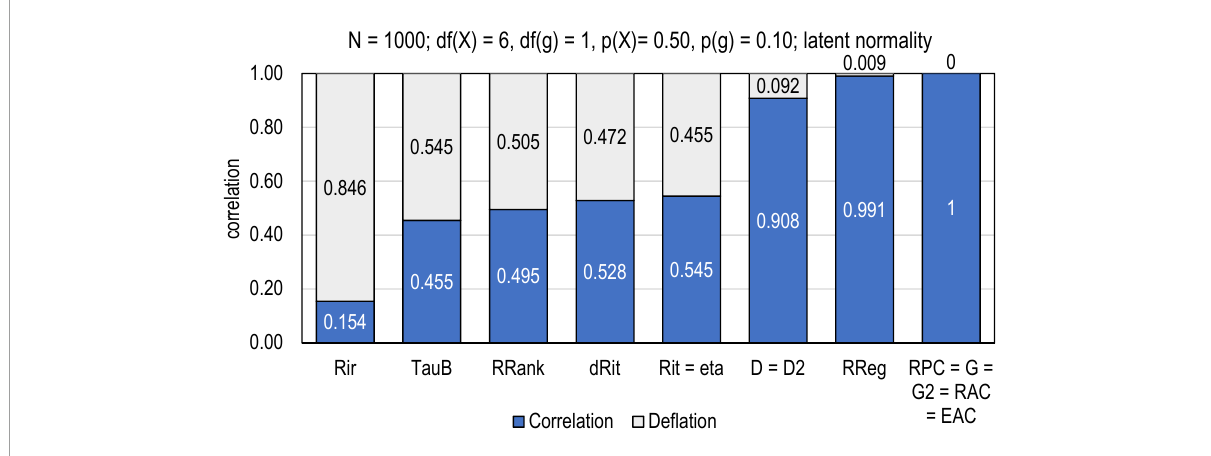
Correlation FIGURE1 Magnitude of deflation in the estimates by selected estimators of association. Rir = Henrysson item–rest correlation (= PMC);Tau-b = Kendall tau-b; RRank = Spearman rank-order correlation (= PMC); dRit = distance correlation; Rit = item–score correlation (= PMC); eta = coefficient eta (X dependent) (= PMC in the binary case); D = Somers delta (X dependent); D2 = dimension-corrected D; RReg = r-bireg correlation; RPC = polychoric correlation; G = Goodman–Kruskal gamma; G2 = dimension-corrected G, RAC = attenuation-corrected Rit; EAC = attenuation-corrected